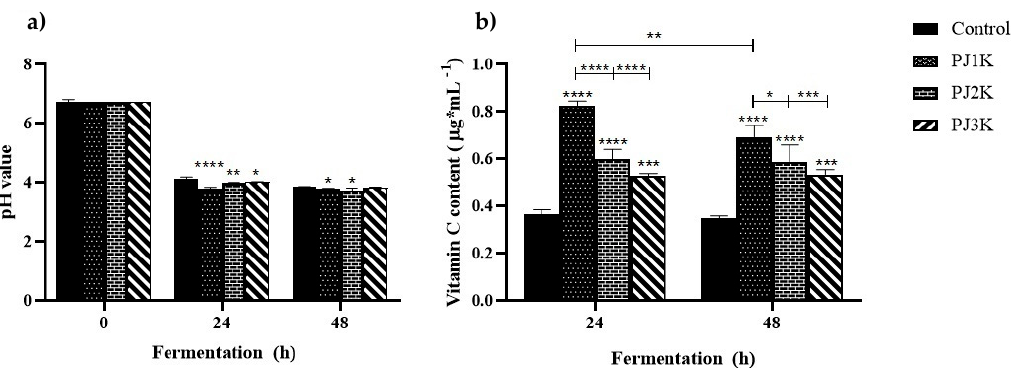
Figure 4. Evolution of pH ( a ) and vitamin C content ( b ) during fermentation, in control and pectin-supplemented kefirs. PJ1K: Kefir added with PJ1. PJ2K: Kefir added with PJ2. PJ3K: Kefir added with PJ3. Values represent the mean of three independent experiments (each done in triplicate) ± standard deviation. Asterisks on the bars indicate that mean values were statistically di ff erent from the control, while asterisks on the dashes indicate di ff erences among di ff erent treatments or the same treatment at di ff erent time points (* p < 0.05, ** p < 0.01, *** p < 0.001, and **** p < 0.0001).